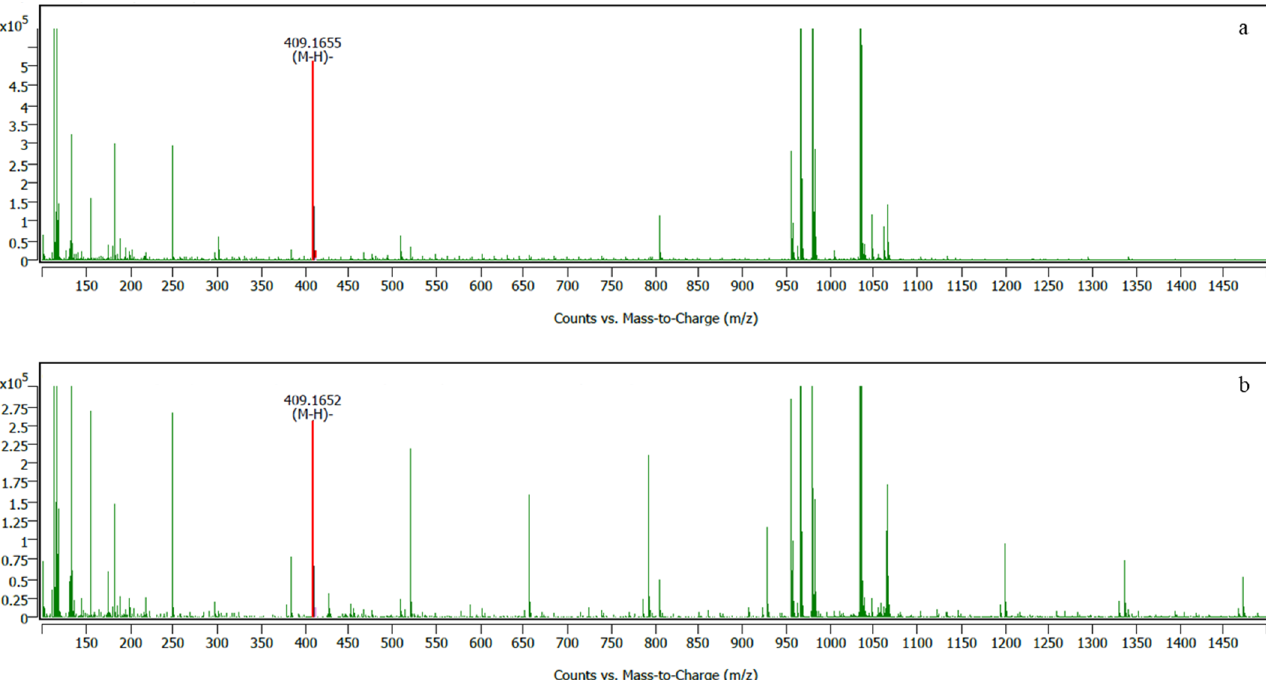
Figure 4. Mass spectrum of MT-MAE-W/E ( a ) and MT-Ma-W/E ( b ) extracts showing α -mangostin (red mark).